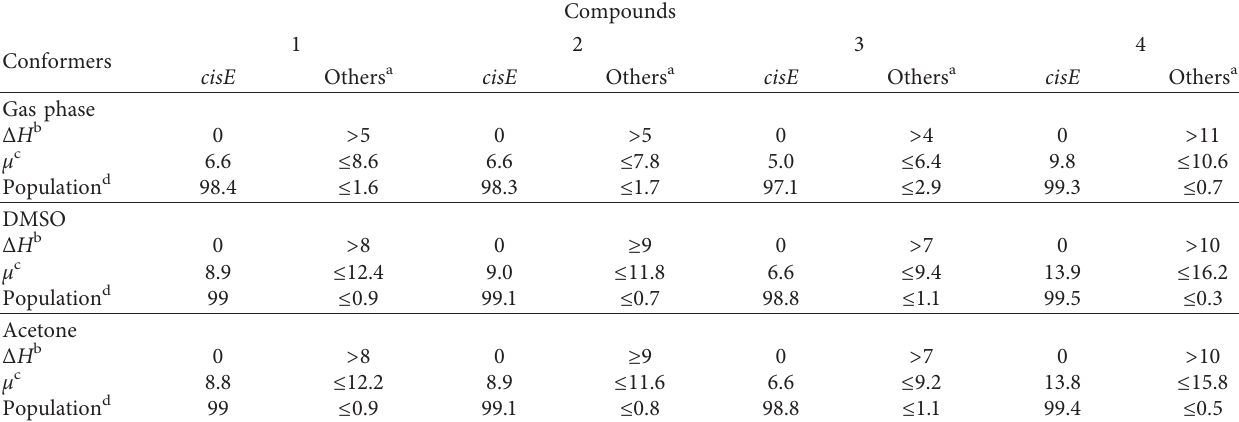
Figure 2: Molecular geometry of the most stable cisE conformers of 1 – 4 optimized at the B3LYP/6–311++G(d,p) level of theory. Dihedral angle Φ in degrees. Table 1: Computational results, at the B3LYP/6–311++G(d,p) level of theory, for the synthesized compounds 1 – 4 .